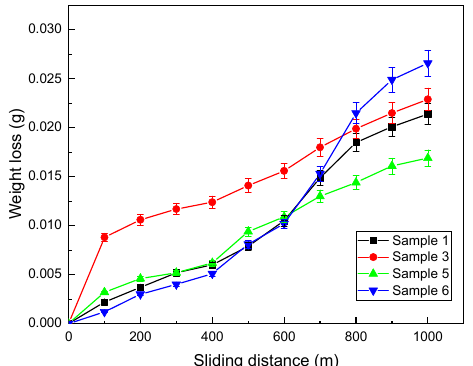
Figure 8. Weight loss in different sliding distances.